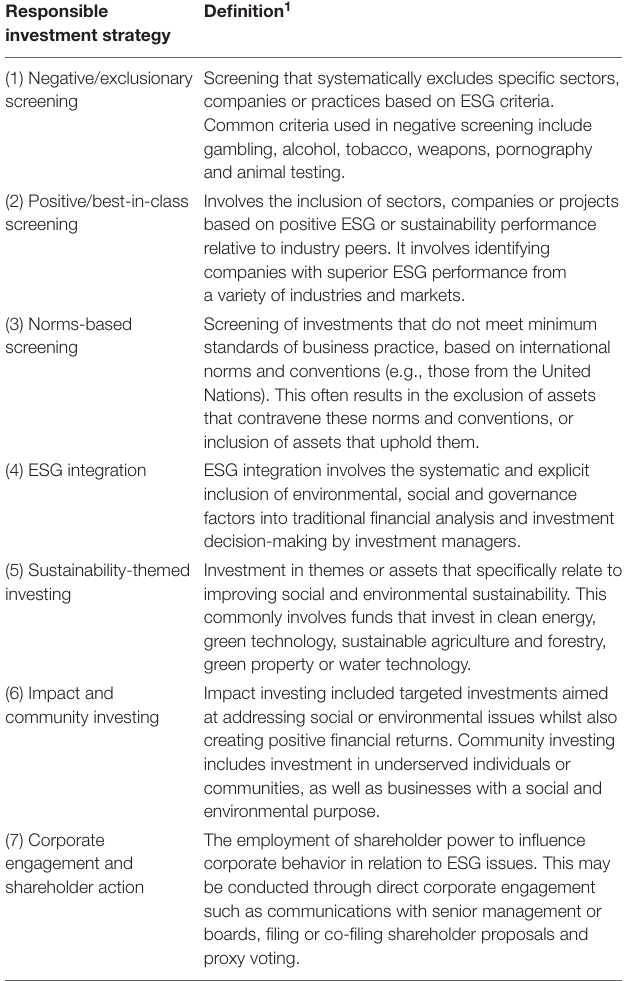
TABLE 1 | Responsible investment strategies and